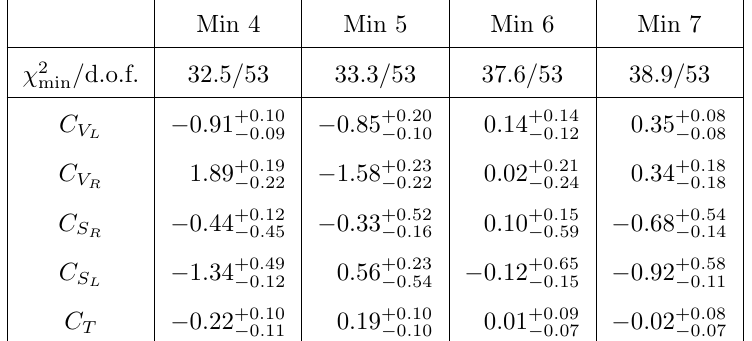
= 0. There are, in addition, the R 6